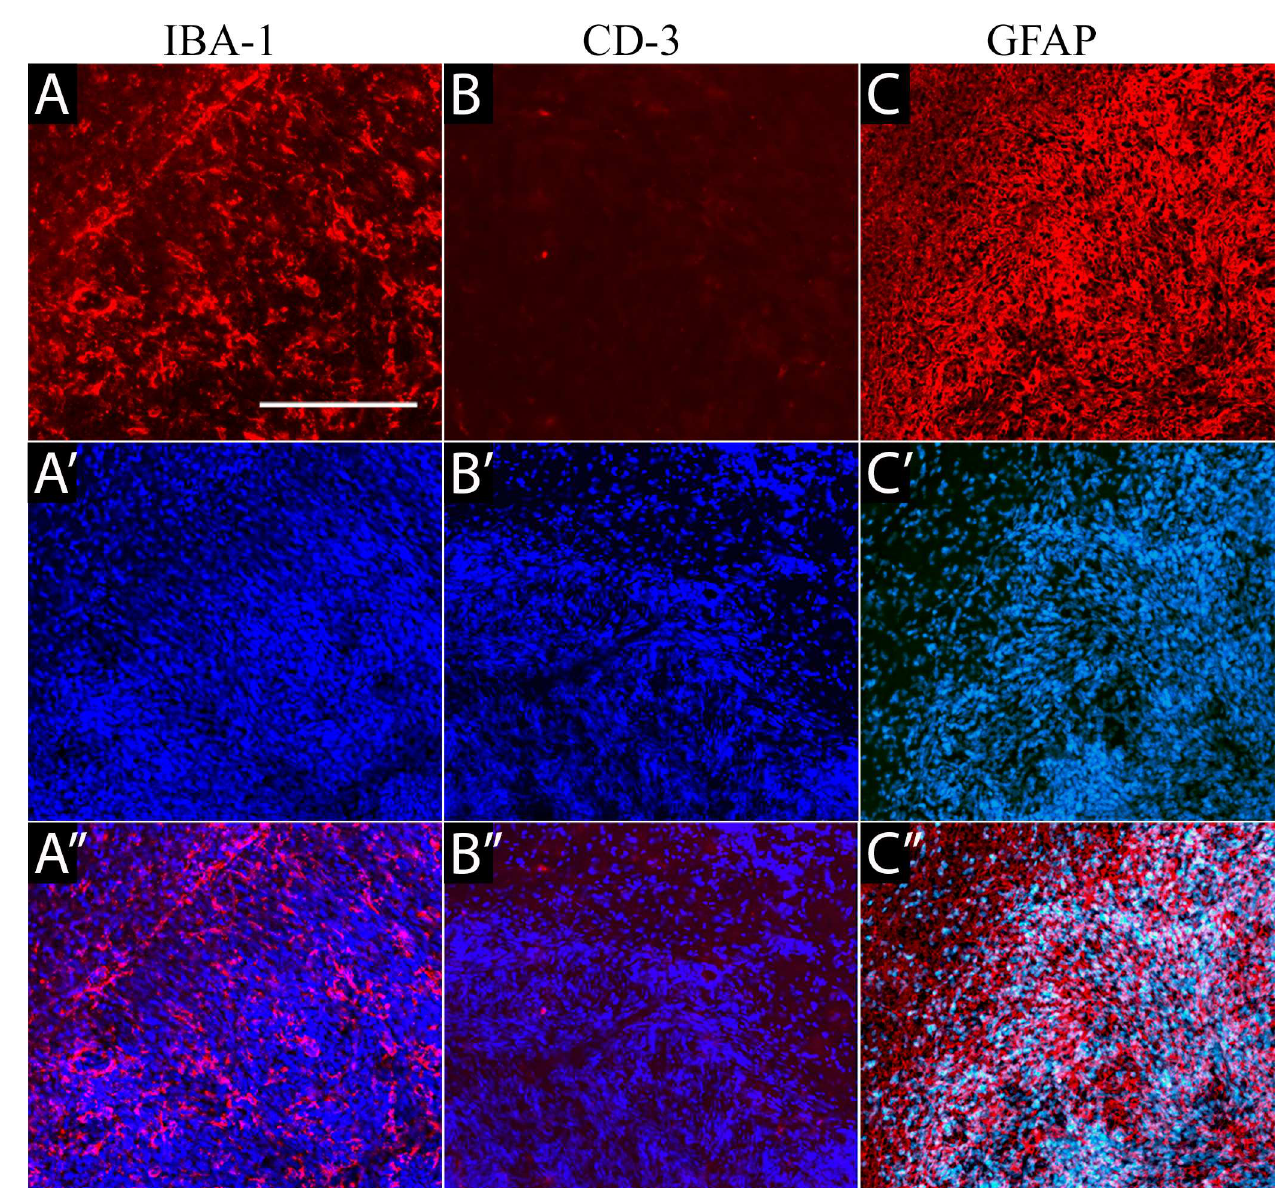
Fig 5. Immunohistochemicalcharacterization of the tumor microenvironment. (A) StainingagainstIBA-1 detected microglialactivation throughoutthe tumor. (B) Immunohistochemistry againstthe T cell marker, CD3, detected very low infiltration, with only single cells observed inside or at the peripheryof the tumor. (C) GFAP immunoreactivity was detected in the tumor with all cells expressinghigh levels of this protein, as well as in the area aroundthe tumor, consistent with activationof surroundingendogenous